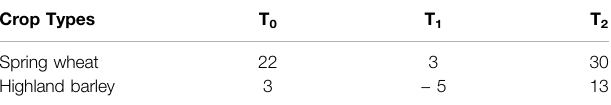
TABLE 2 | Optimum temperature and temperature limits of main crops during the growth period. Crop